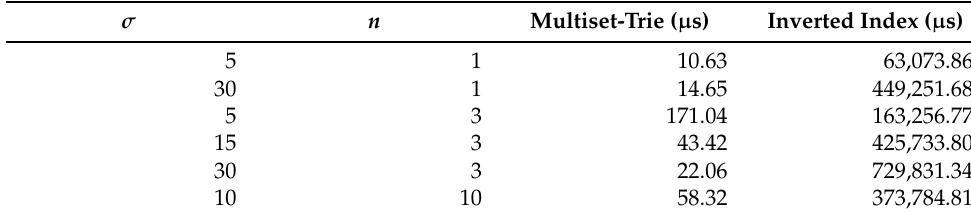
Table 4. Super-multiset